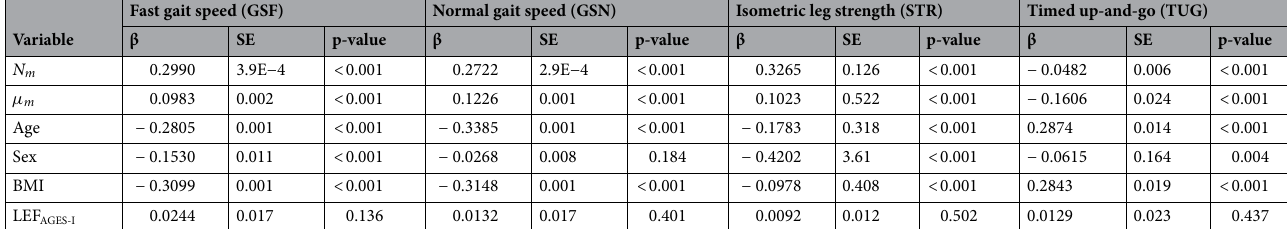
Table 4. Multivariate multiple regression models of the relationship between LEF AGES-II and NTRA AGES-II parameters significantly related to PA AGES-I . All eight PA AGES-I hypothesis tests surpassed their respective thresholds for HB correction.